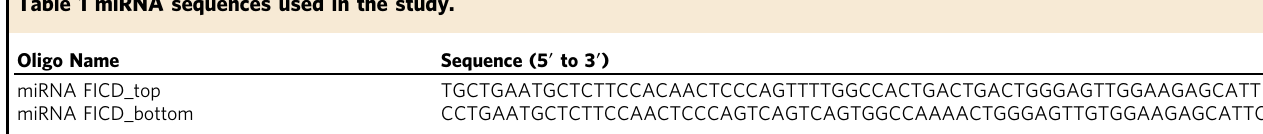
Table 1 miRNA sequences used in the